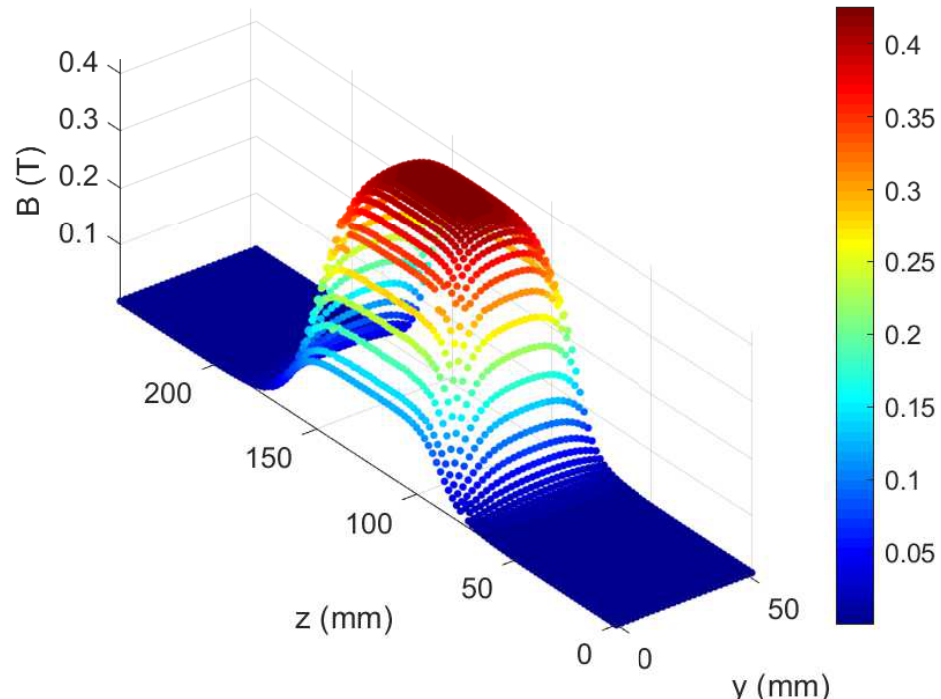
Figure 2. Measured magnetic field distribution. Ions propagate in z-direction through the field towards the MCP, deflected on the y-direction by the Lorentz